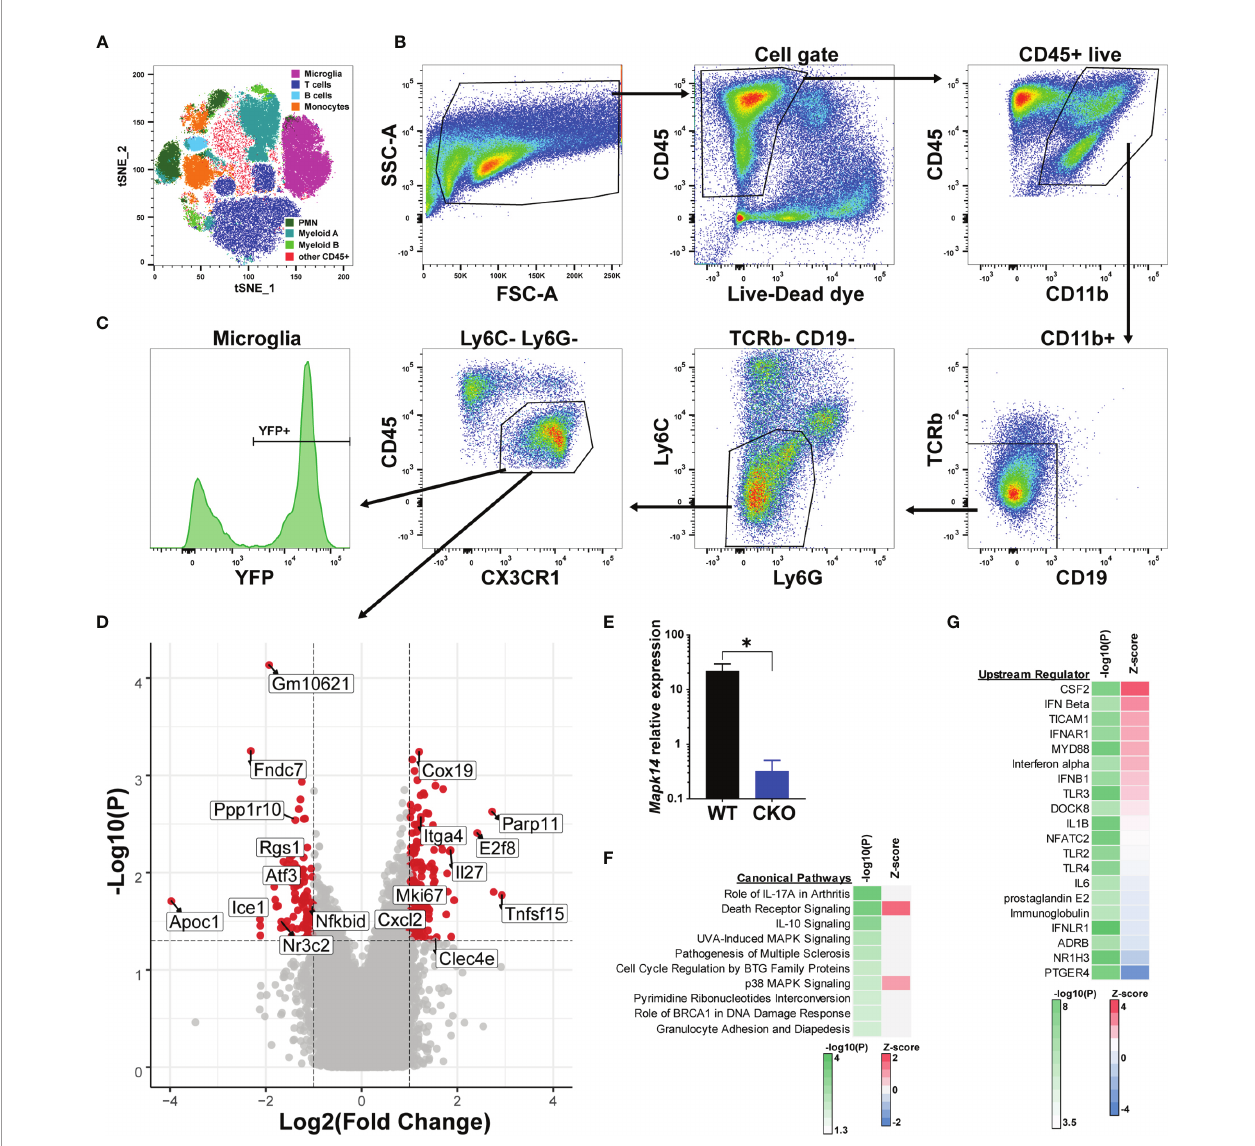
FIGURE 4 | Bulk transcriptional pro fi ling reveals p38 a -dependent gene signatures in microglia. Male p38 a CKO Cx3cr1-ER (CKO; n=4) and WT control (n=6) mice were treated with tamoxifen for 4 days, followed by a 4 week rest period, at which point EAE was induced. On day 21 post-EAE induction, mononuclear cells were isolated from the brain and spinal cord by Percoll gradient, followed by FACS analysis and isolation of microglia, followed by RNA isolation and microarray analysis (see Materials and Methods). (A) FlowJo-based tSNE analysis of FACS data demonstrating the major cell populations identi fi ed by FACS. (B) Representative gating scheme and FACS data for microglia isolation. (C) Reporter YFP expression in microglia. (D) Volcano plot demonstrating differential gene expression in CKO vs . WT microglia, passing the threshold of |FoldChange|>2 and P<0.05. Select genes are annotated. Positive fold change indicates higher expression in CKO. (E) qRT-PCR analysis of Mapk14 (p38 a ) mRNA expression in sorted WT and CKO microglia, normalized by B2m house-keeping gene expression (*10000). (F, G) Genes differentially expressed in CKO vs . WT were subjected to bioinformatic analysis using Ingenuity software (see Materials and Methods). Top 10 canonical pathways, as identi fi ed by P-value of enrichment are shown in (F) , with Z-score indicating enhanced predicted activity in CKO. Top 20 predicted upstream regulator nodes, as identi fi ed by absolute Z score are shown in (G)